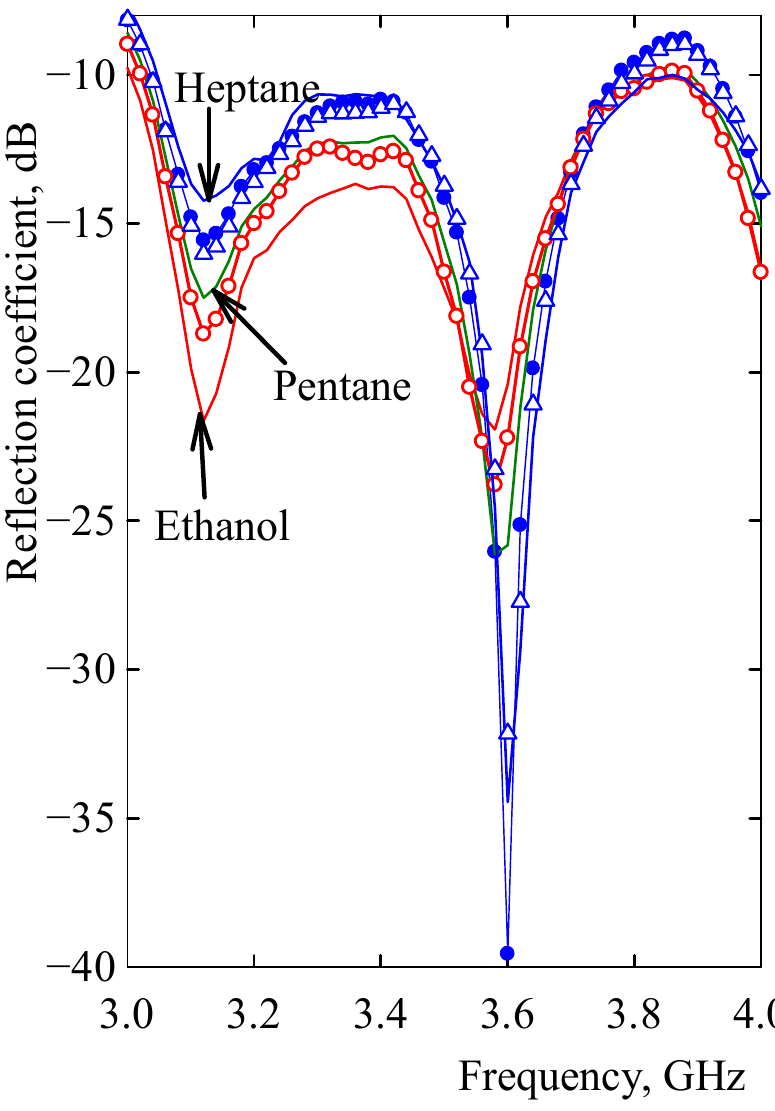
Figure 13. The frequency dependence of the reflection coefficient after 120 s exposure to non-polar heptane and pentane, polar ethanol, and their different mixture ratios. Thin lines are for particular pure vapors denoted in the figure. The blue line denotes heptane, dark green—pentane, and the red line denotes ethanol. Blue filled circles denote mixture 1 (heptane/pentane/ethanol in volume ratio 50:30:20), open blue triangles denote mixture 2 (30:50:20), and open red circles denote mixture 3 (10:20:70).